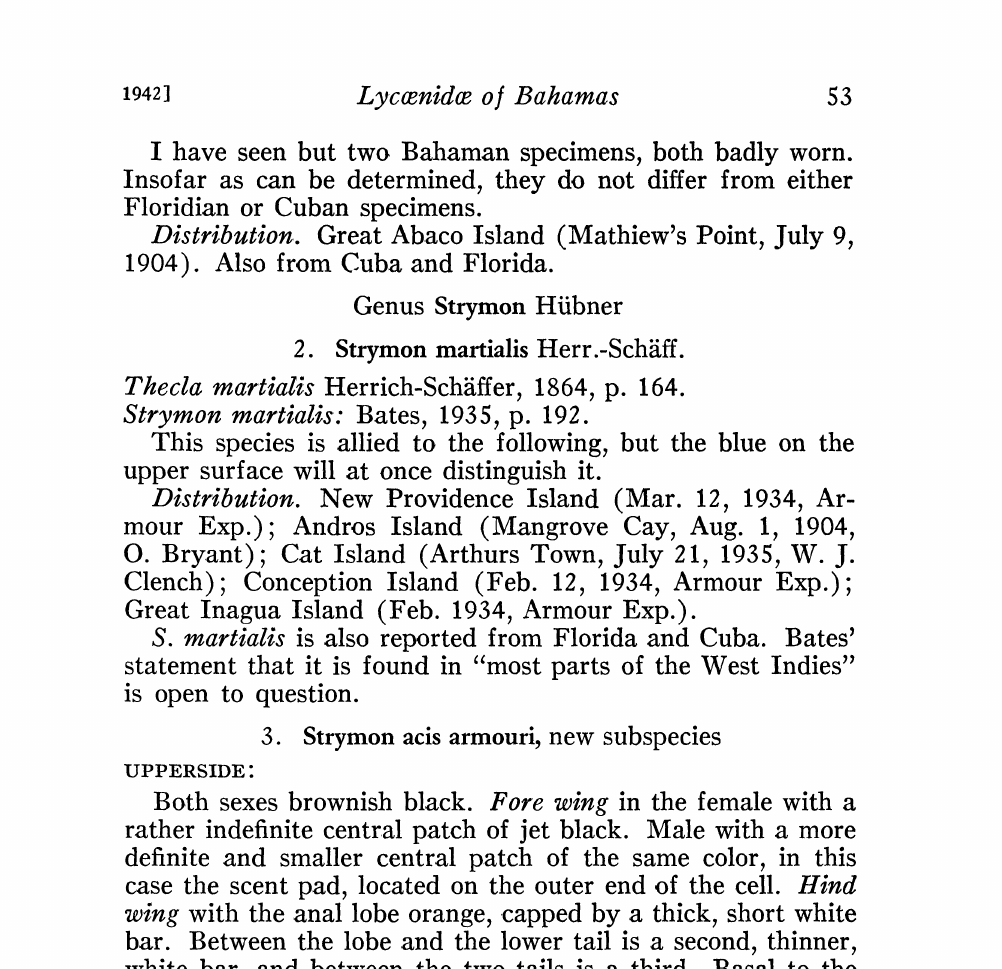
rather indefinite central patch of jet black. Male with a more definite and smaller central patch of the same color, in this case the scent pad, located on the outer end of the .cell. Hind wing with the anal lobe orange, .capped by .a thick, short white bar. Between the lobe and the lower tail is .a second, thinner, white bar, and between the two tails is a third. Basal to the second of these bars is a small, frequently obsolete, patch of white scales. Basal to the third bar is a patch of orange scales. The tail at Cu is the shorter, as is customary in the genus, and both that .and the one at Cu2 are black, tipped with white. Fringe of both wings white, except at the anal lobe and the costal part of the outer margin of the hind wing which are